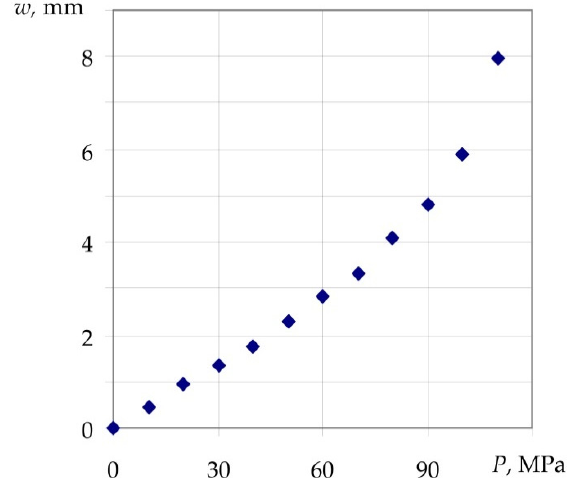
Figure 8. Axial displacements w of the translucent element at short-term loading by the hydrostatic pressure P.